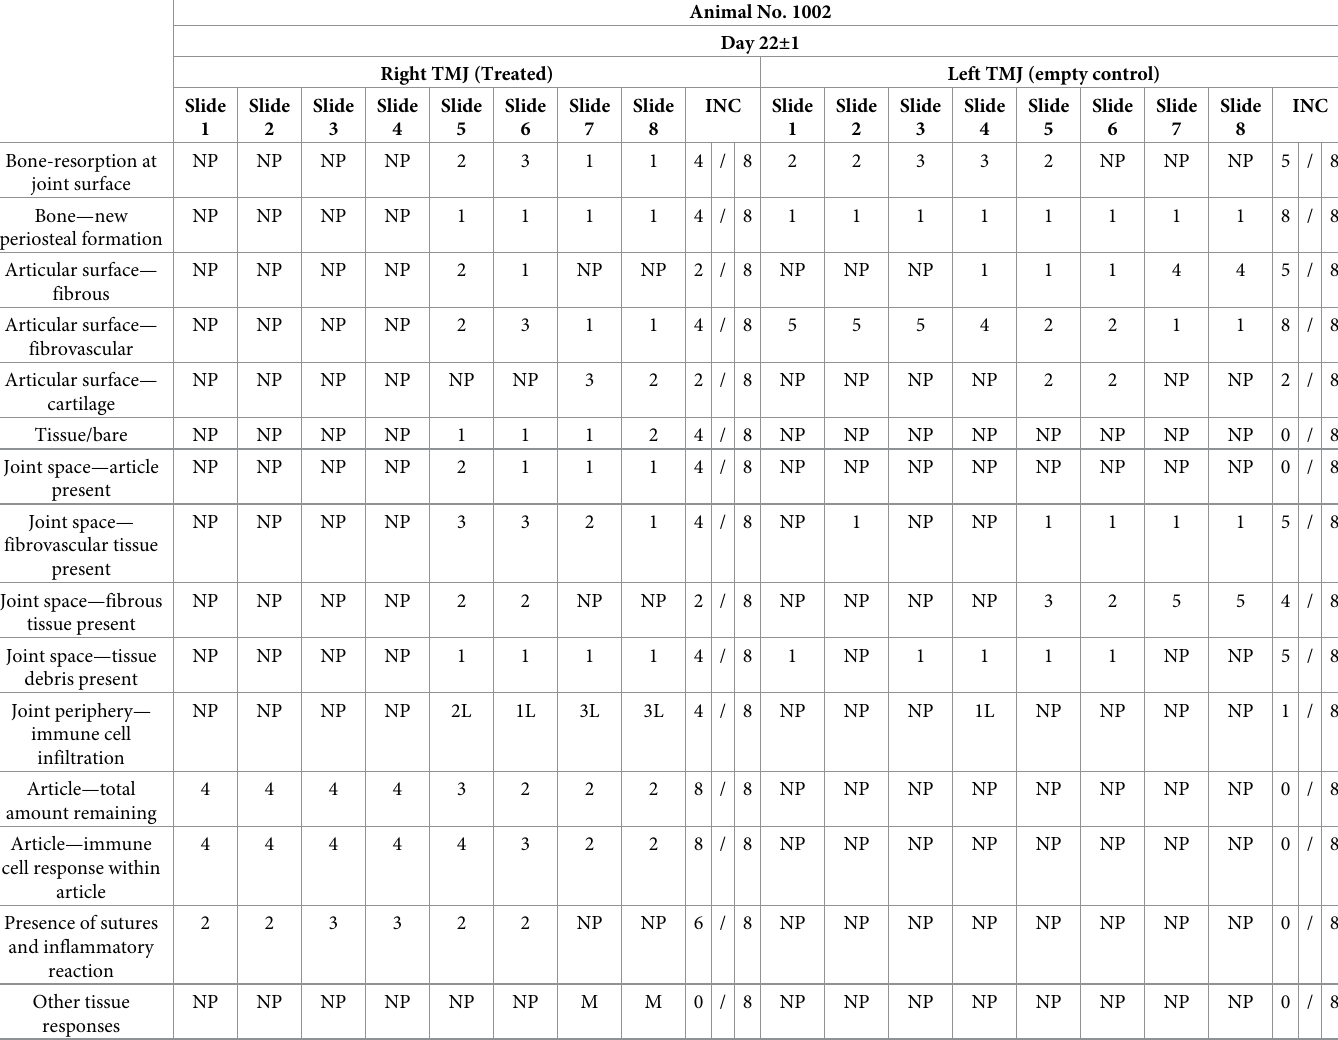
Table 9. Individual histopathological findings for animal